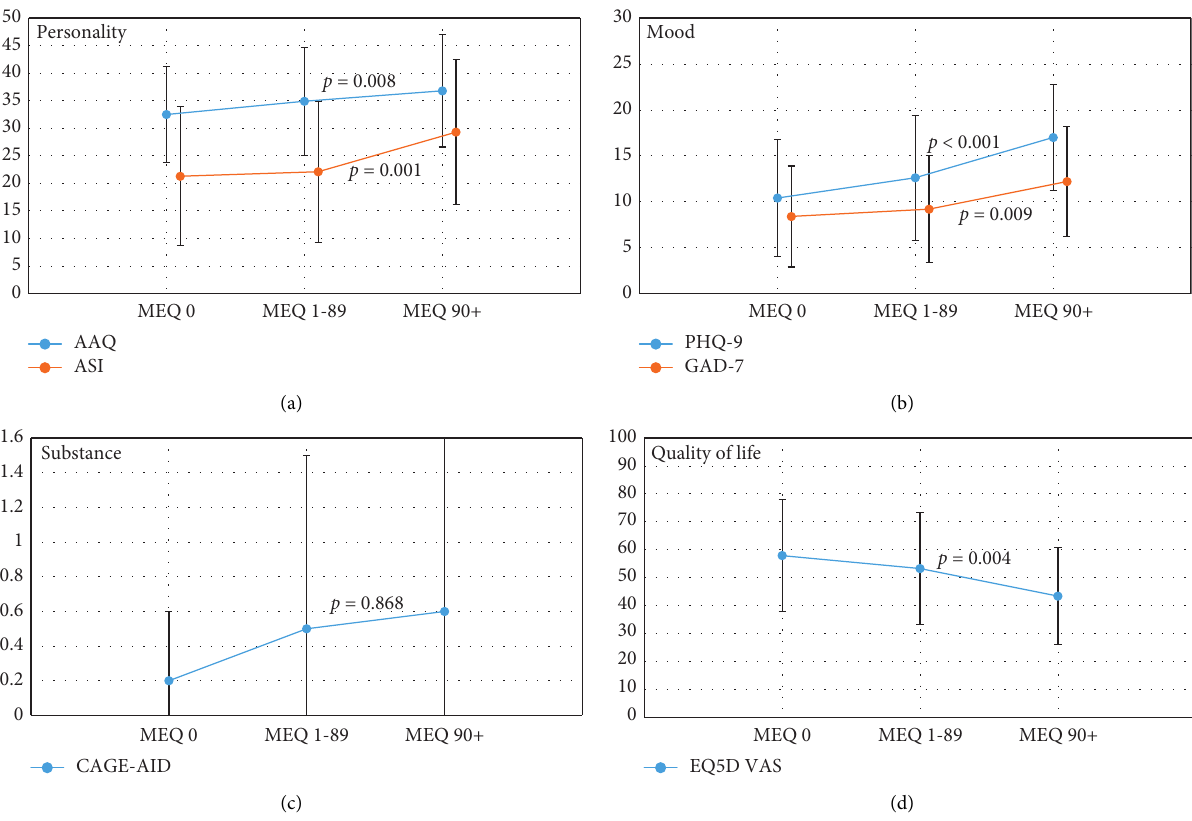
Figure 1: Mean and standard deviation for outcome measure scores among the three MEQ groups (0, 1–89, 90+) for (a) personality traits (AAQ, ASI), (b) mood (PHQ-9, GAD-7), (c) substance misuse (CAGE-AID), and (d) quality of life